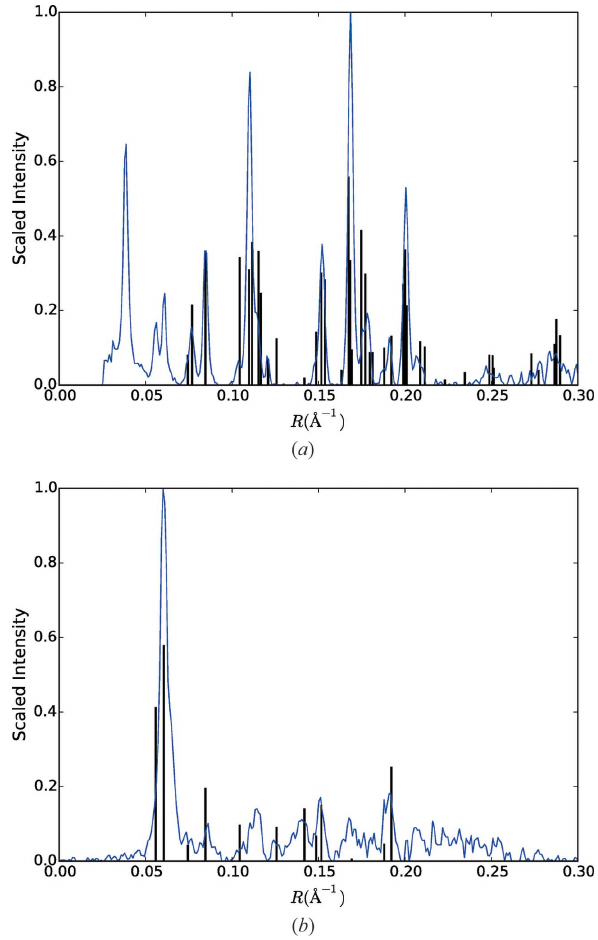
Figure 14 Cylindrically averaged intensity profiles (blue curve) overlaid with the measured structure intensities (bars) for ( a ) l = 0 and ( b ) l =